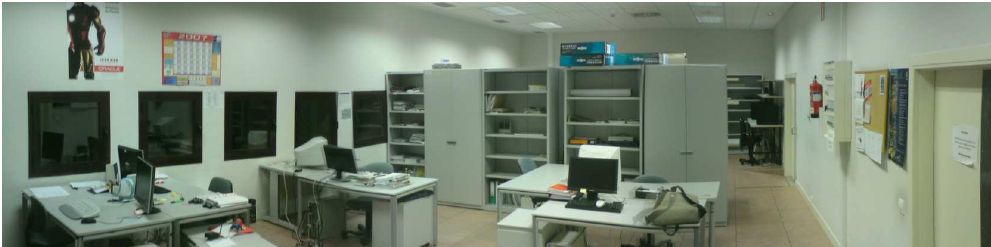
Figure 1. Office scenario picture.